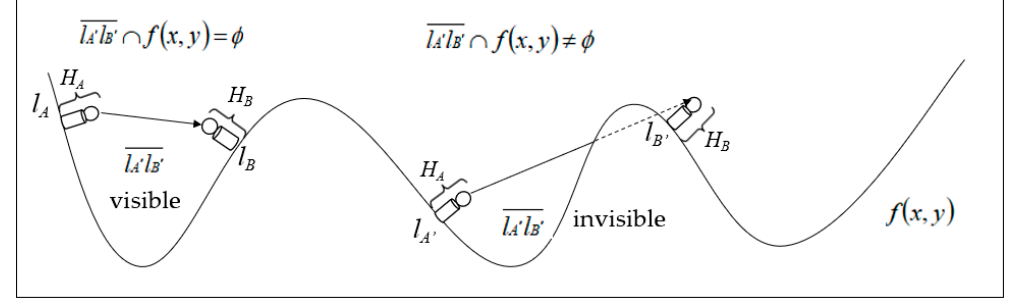
Figure 3. Two relationships between sight and terrain.